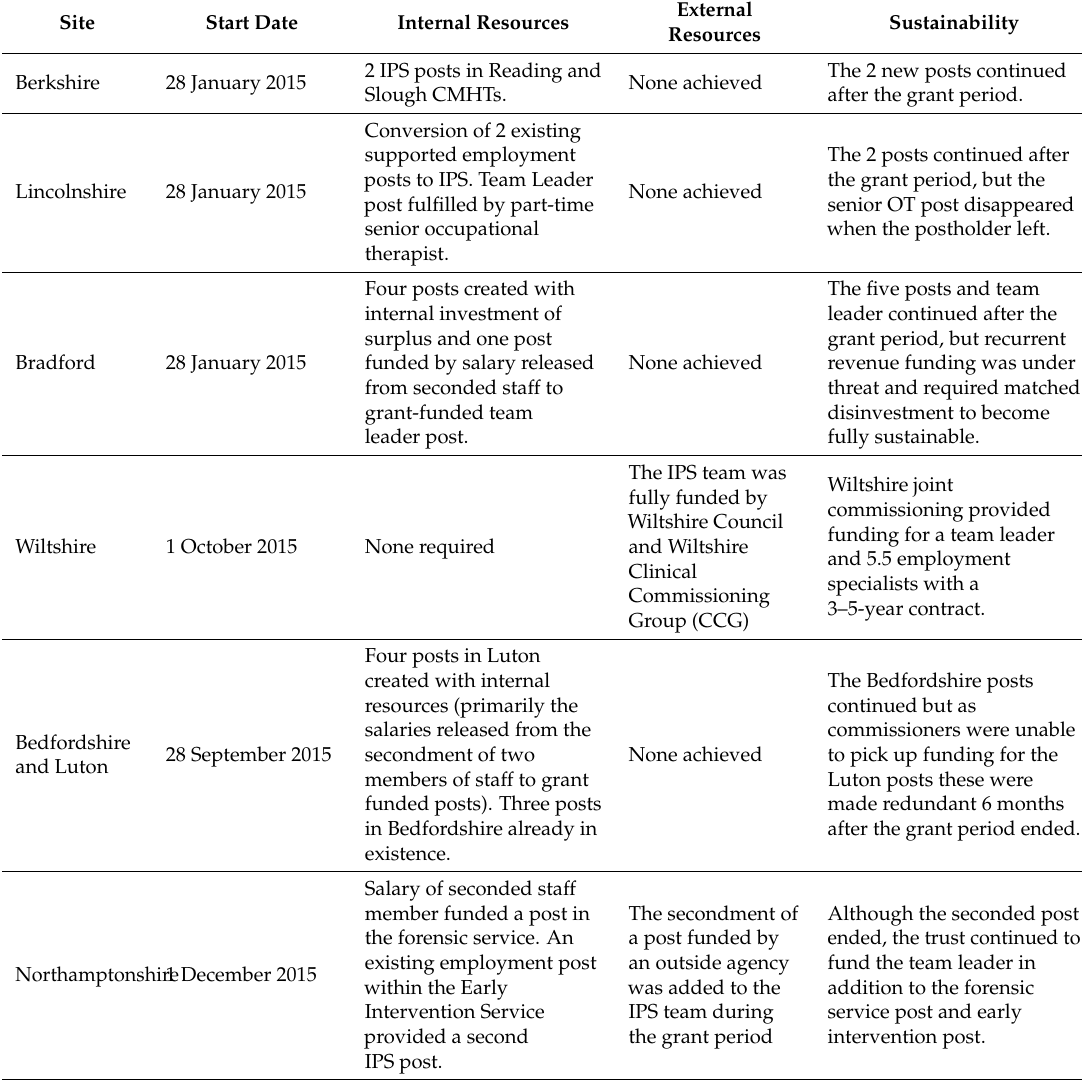
Table 1. The sites and Funding for Employment